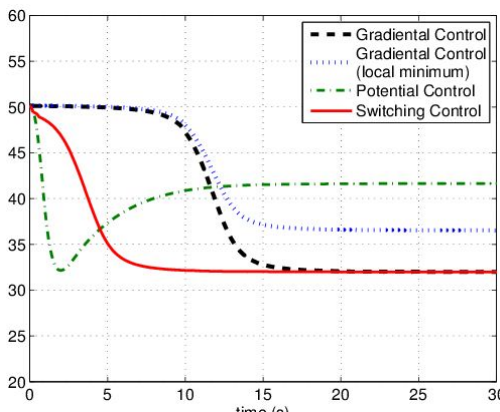
Figure 3. Cost function